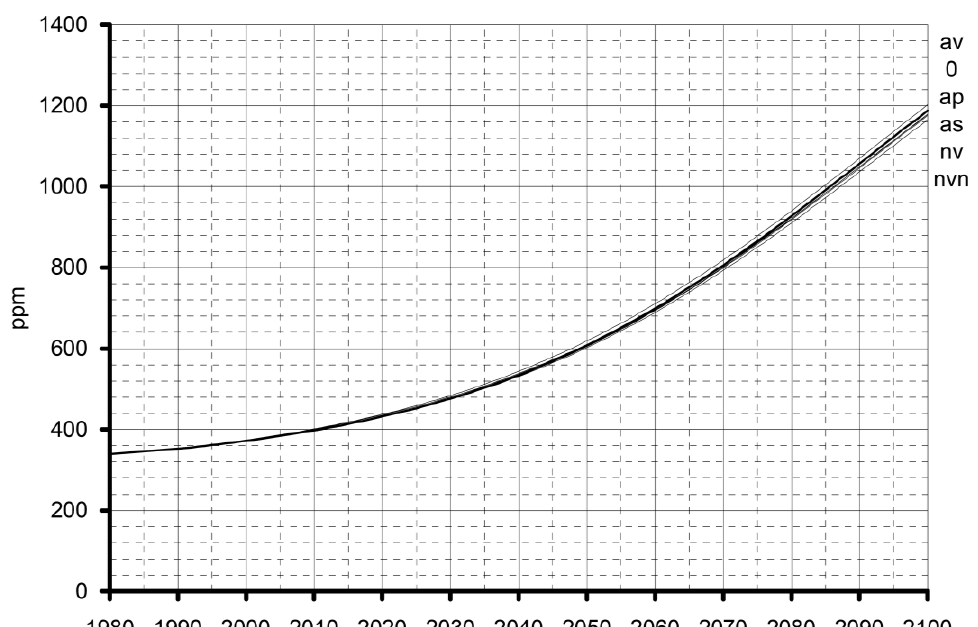
without usage of deforested areas for energy)